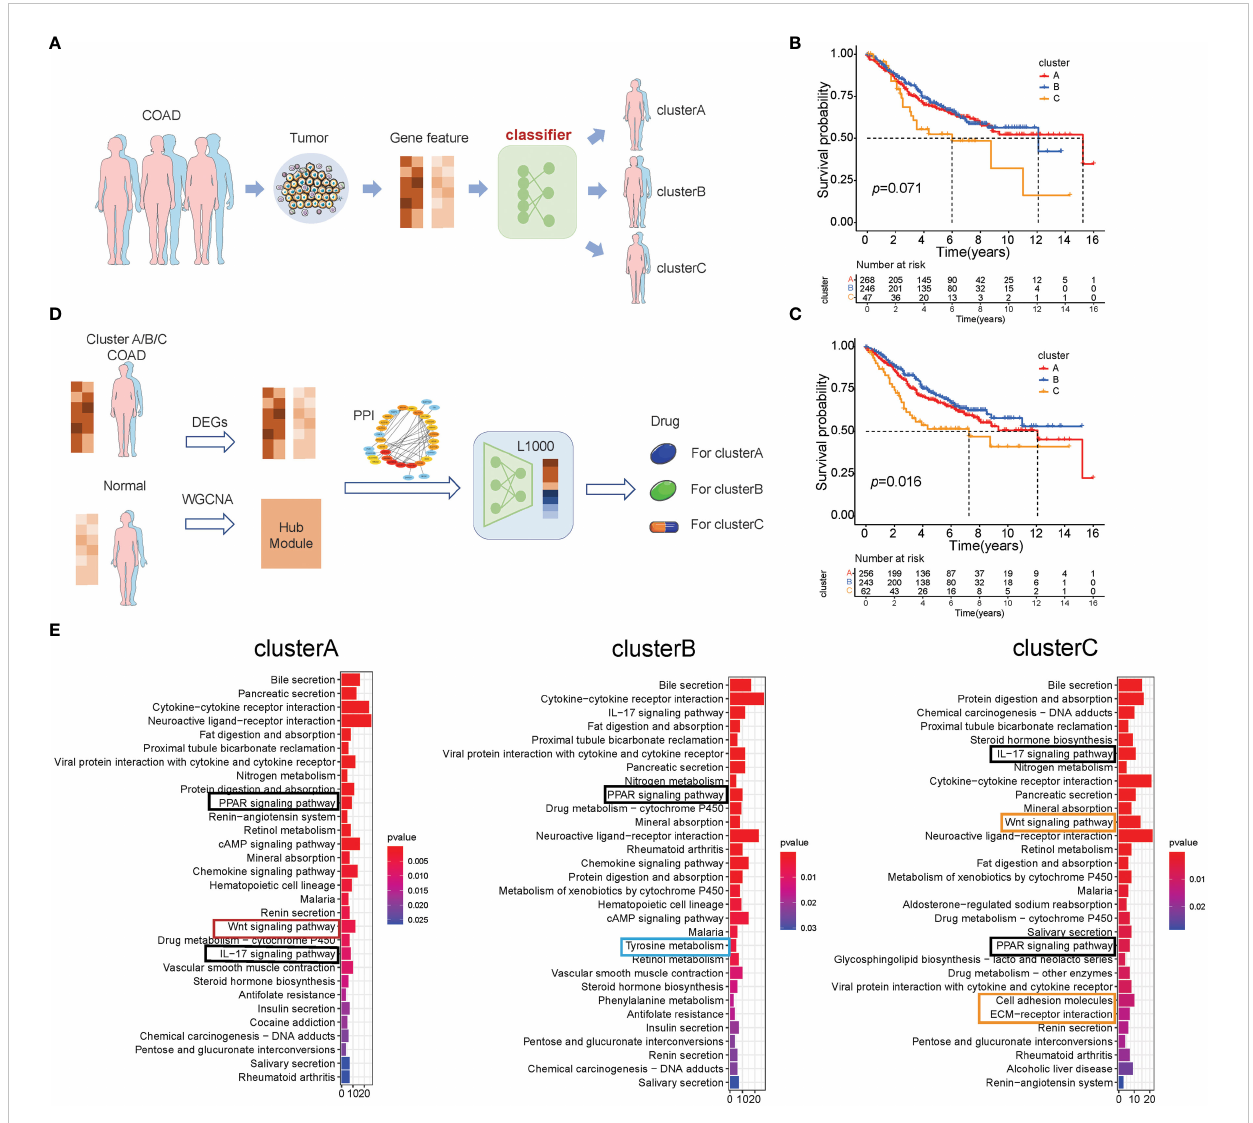
FIGURE 4 Classi fi cation-drug-prediction system. (A) Flow chart of the COAD subtype prediction. (B) For the GSE39582 cohort, if the distance from the centers of the three subtypes in TCGA-COAD was used as a classi fi cation standard, then the result of the survival analysis is not signi fi cant (log-rank test). (C) For the GSE39582 cohort, the MLP model was used to do classi fi cation, and the result of the survival analysis is signi fi cant (log-rank test). (D) Flow chart of drug screening for different molecular subtypes. (E) GO analysis of the intersection genes in the WGCNA and DEGs (patients vs . controls) of TCGA-COAD clusters A – C,